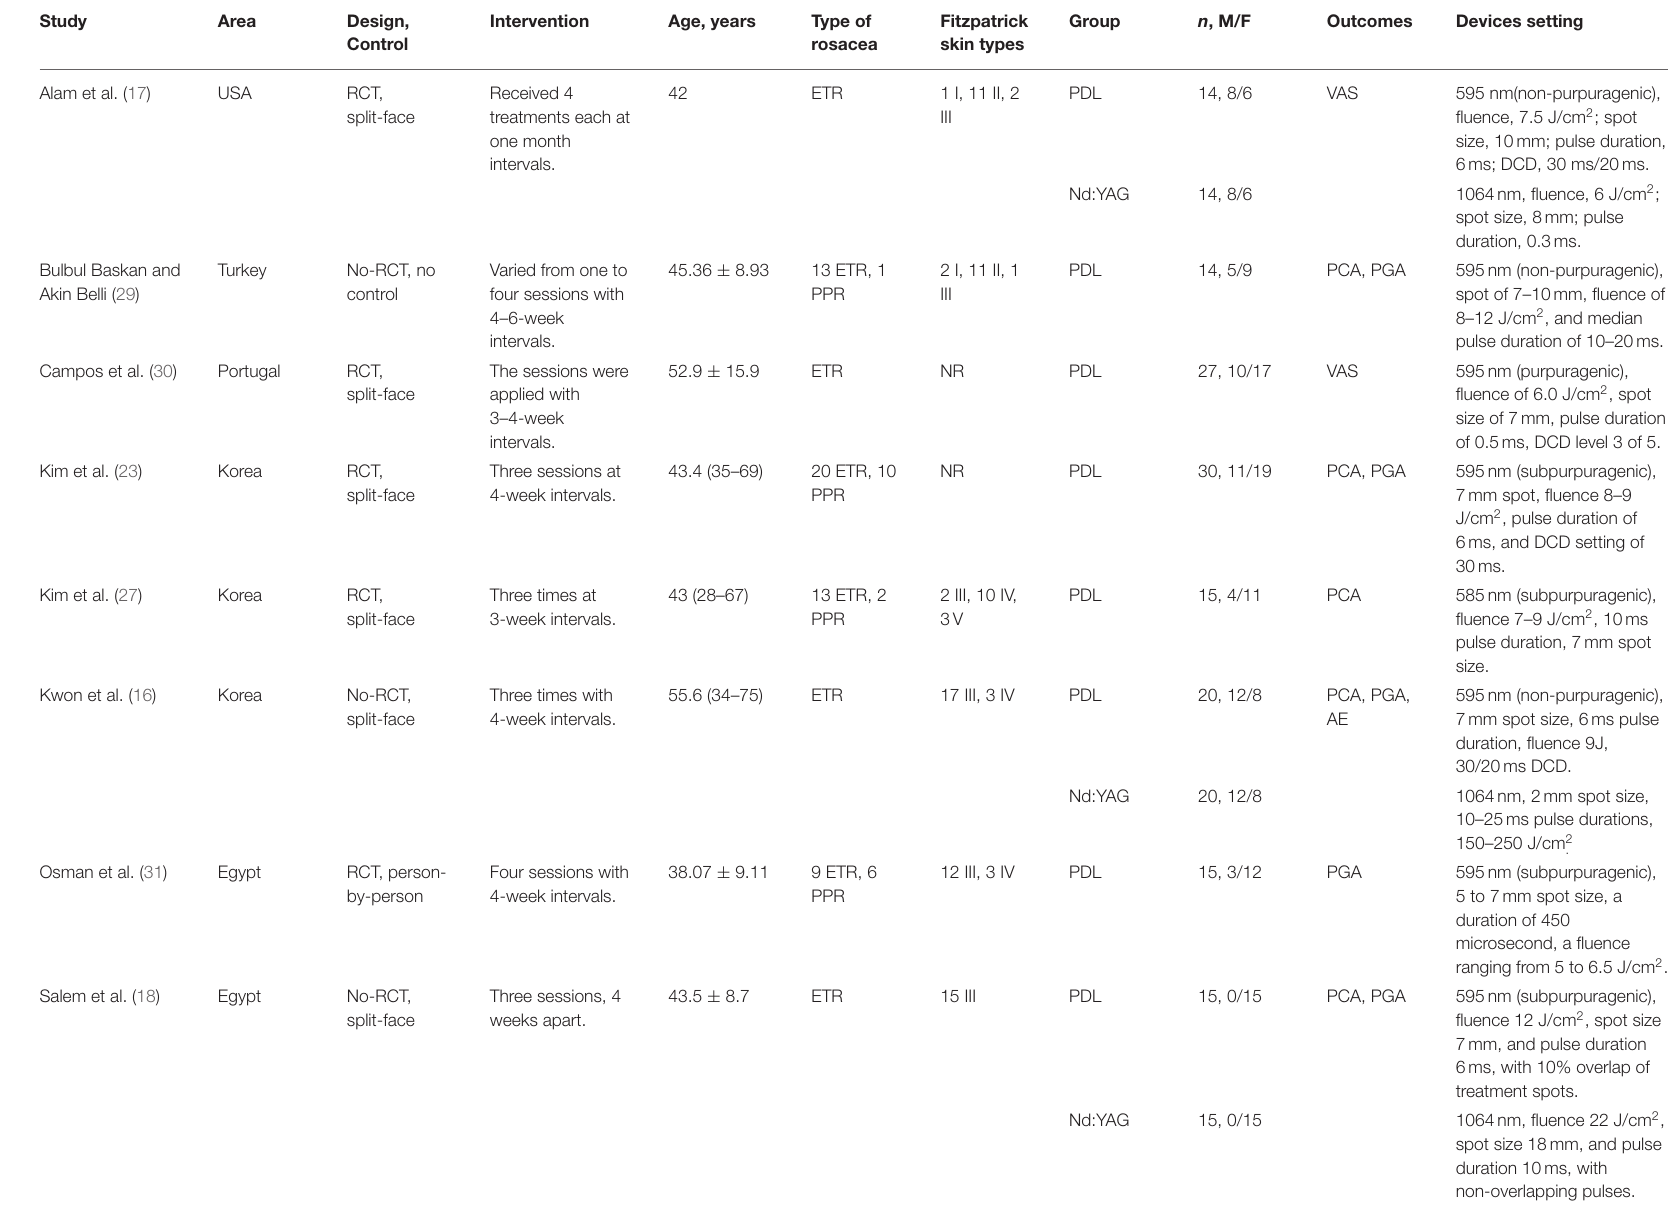
TABLE 1 | Characteristics of ten studies included in this